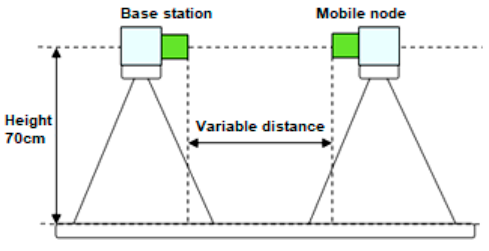
Figure 14. Indoor / outdoor measurement setup.